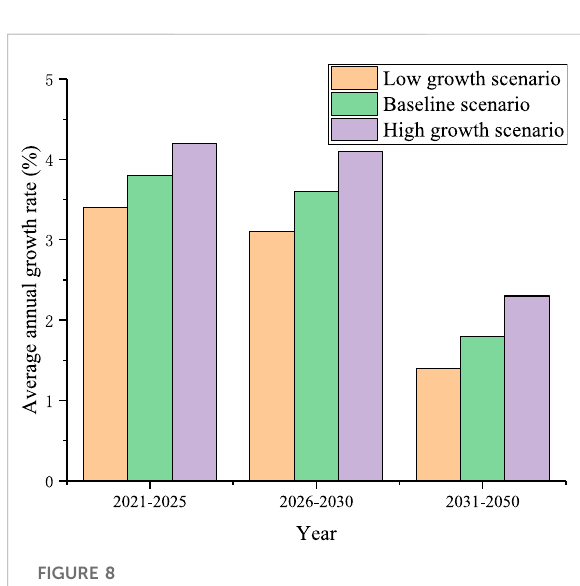
FIGURE 8 Forecast results ofregional ruralenergy demand growth